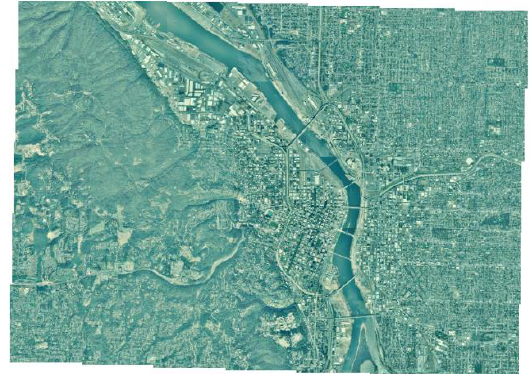
Fig.2.2 Original MD without image footprint before color balance.